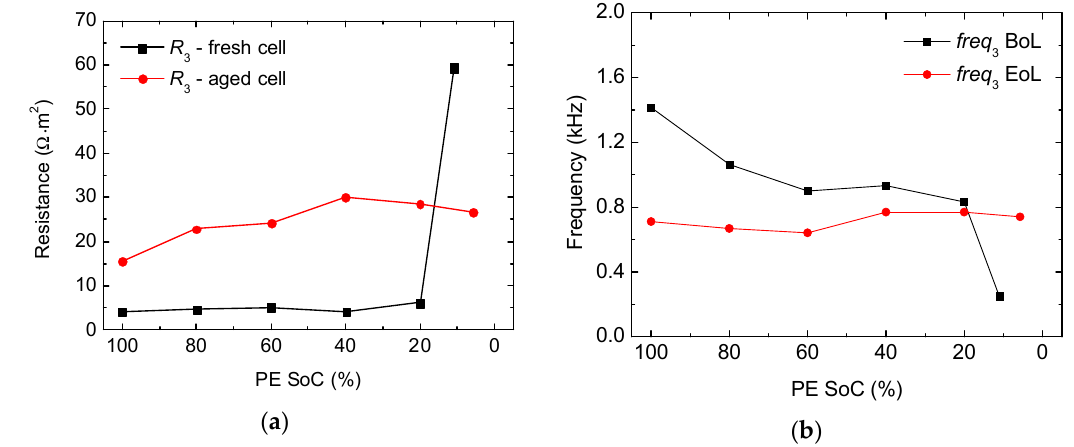
Figure A3. ( a ) Resistance and ( b ) characteristic frequency related to P3_PE measured at the LCO-NMC/Li half-cell at 25 °C.